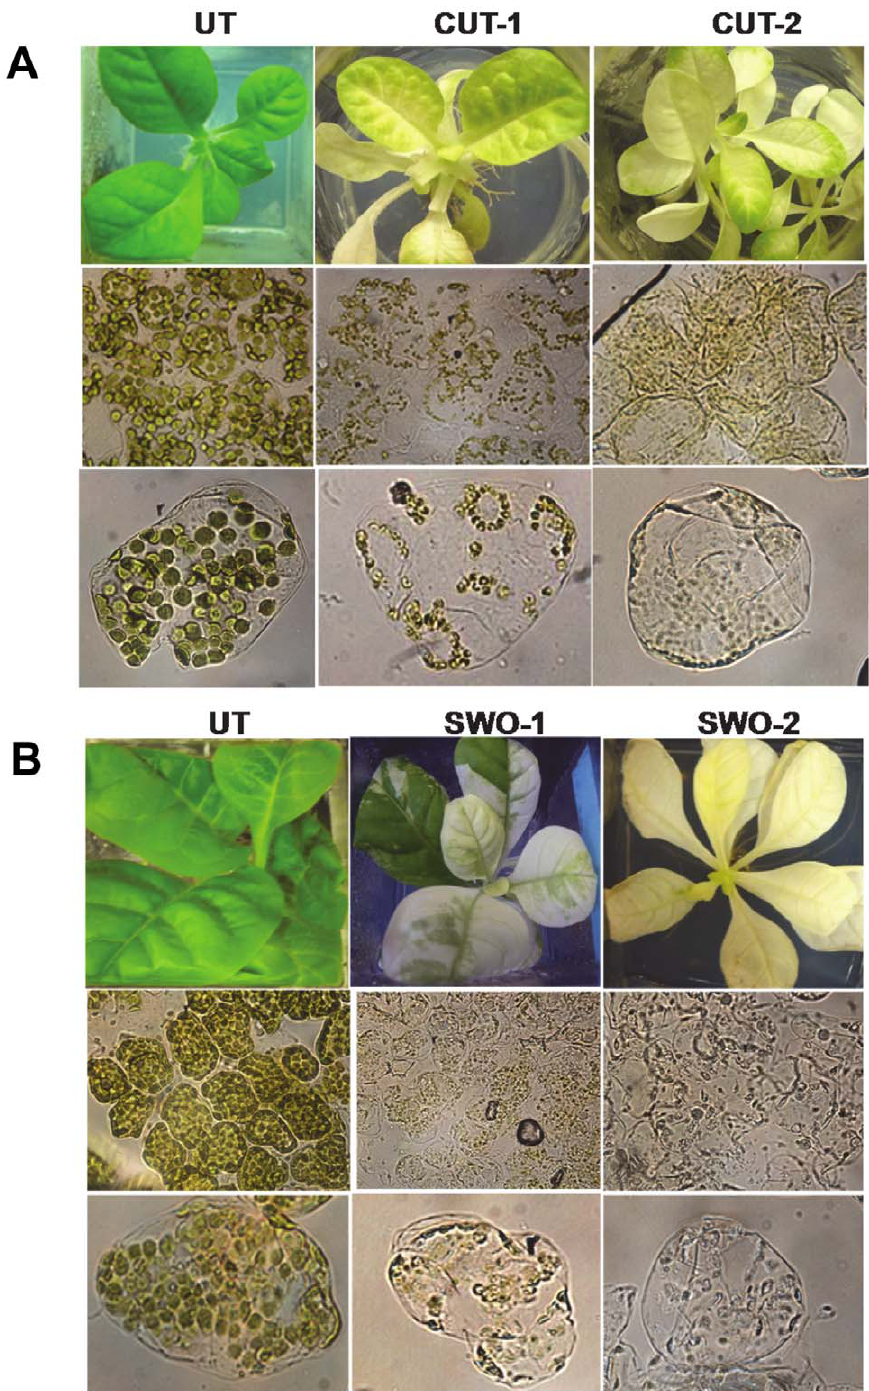
Figure 2. Microscopic evaluation of mesophyll cells. A, Untransformed and cutinase transplastomic lines (UT, untransformed; CUT-1 and CUT-2, cutinase transplastomic lines). Lower panel is an enlarged view. B, Untransformed and swollenin transplastomic lines (UT, untransformed; SWO1-1 and SWO1-2, swollenin transplastomic lines). Lower panel is an enlarged view. The chloroplasts were observed at 60X magnification under a Leica inverted microscope outfitted with a Leica